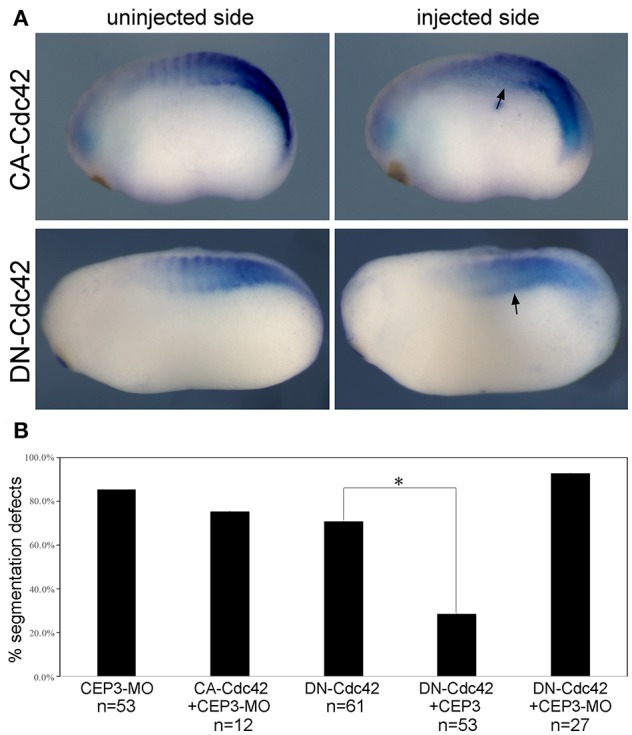
Cdc42 needs to be tightly controlled during somite segmentation. (A) 0.05 ng of constitutively active (CA) or dominant negative (DN) Cdc42 was injected into one side of the embryo, and their effect on somite segmentation was examined by the expression of myod1. Comparing to the uninjected control side, the segmented expression pattern of myod1 was lost on the injected side (arrows), suggesting that both increased and decreased activity of Cdc42 will affect somite segmentation. (B) CA-Cdc42 was co-injected with CEP3-MO, and CEP3 or CEP3-MO was co-injected with DN-Cdc42 to determine whether they can rescue segmentation defects caused by CEP3 or Cdc42 knockdown. The percentage of embryos with segmentation defect was summarized in the bar graph. χ2 test indicates that CA-Cdc42 failed to rescue segmentation defects caused by CEP3-MO (p = 0.52), but CEP3 significantly rescued segmentation defects caused by DN-Cdc42 (*p < 0.01). Coinjection of CEP3-MO with DN-Cdc42, on the other hand, further inhibited somite segmentation (p = 0.02 when comparing with DN-Cdc42 alone).